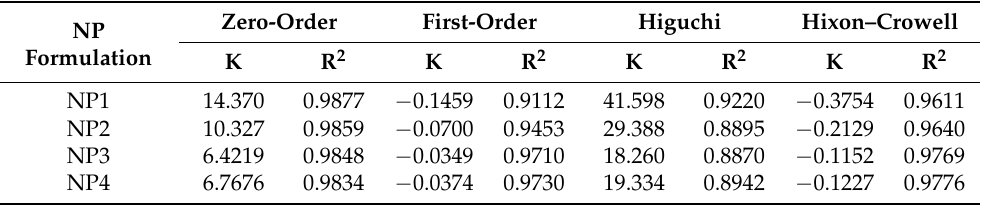
Table 2. Release kinetics of PTX from NPs at pH 7.4.